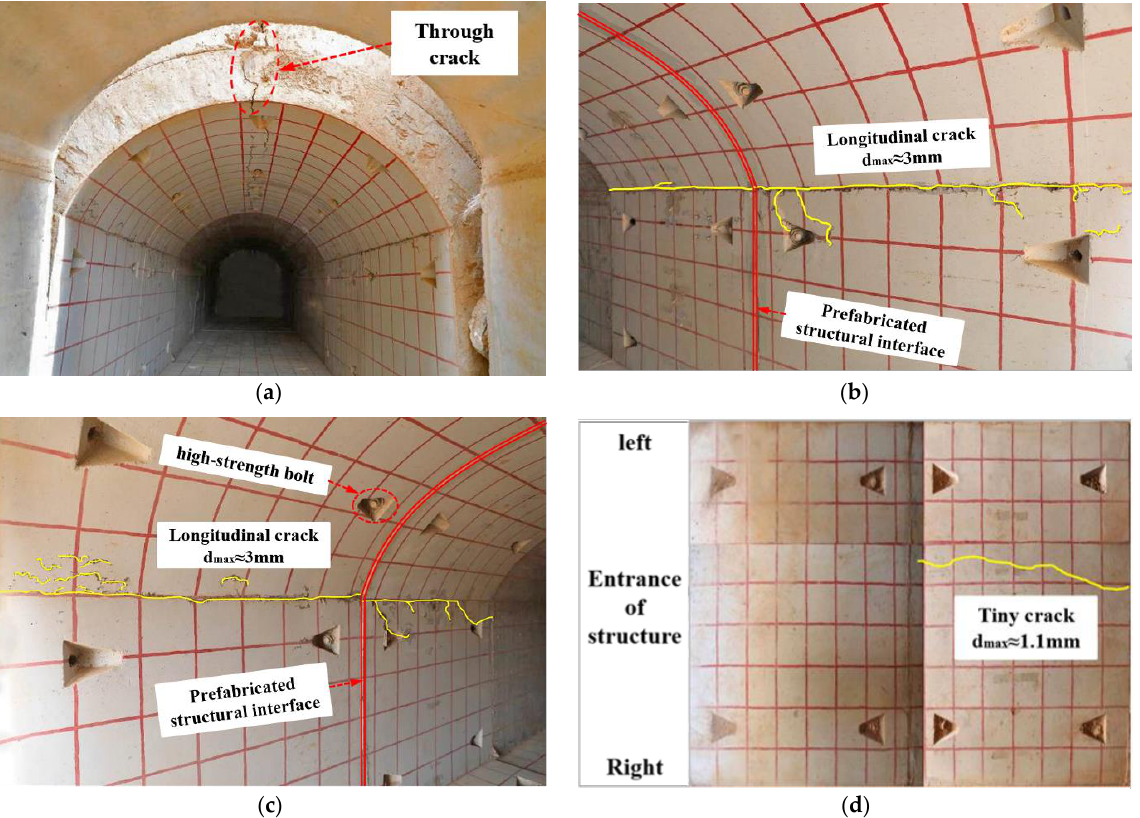
Figure 9. The damage state of test section A: ( a ) the photograph of the internal structure; ( b ) the damage state of the left arch spring; ( c ) the damage state of the right arch spring; ( d ) the damage state of the floor.